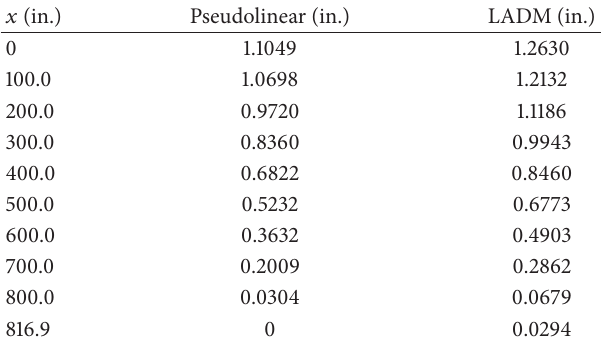
Table 3: Numerical results of slope